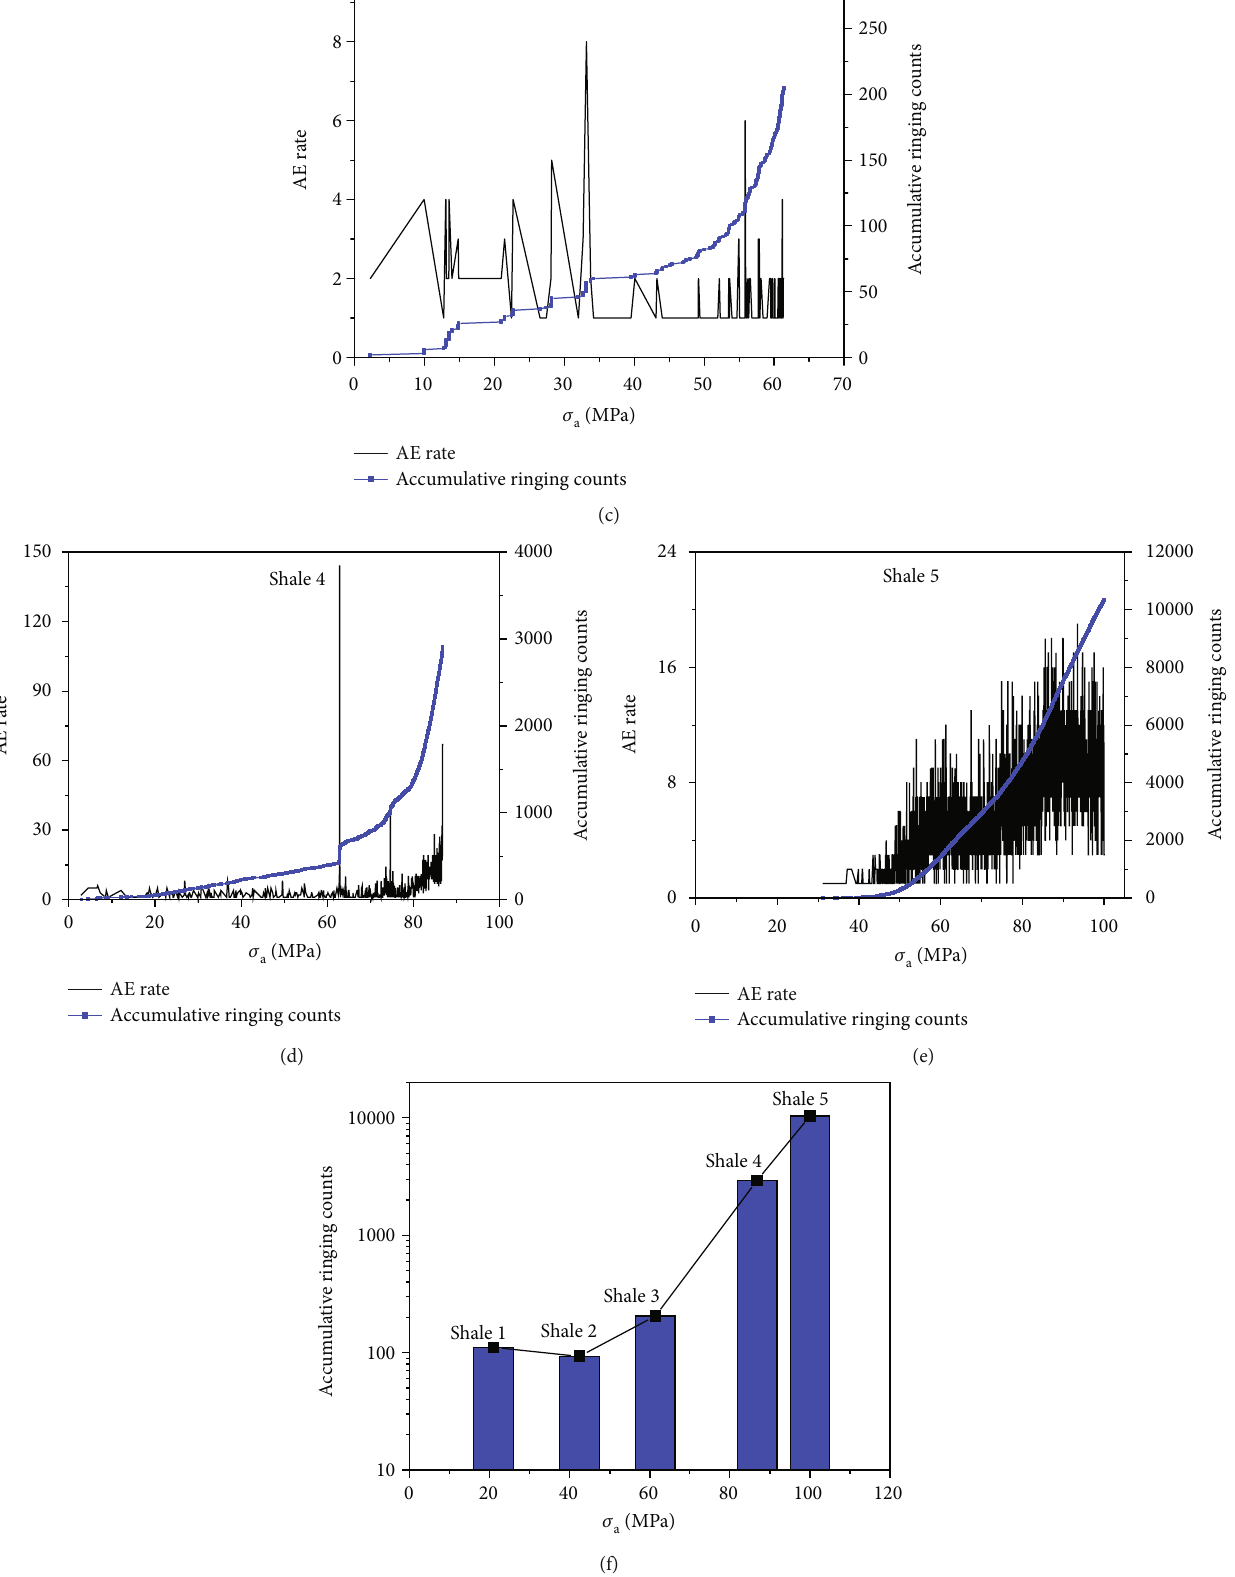
Figure 7: AE rate and accumulative ringing counts under loading